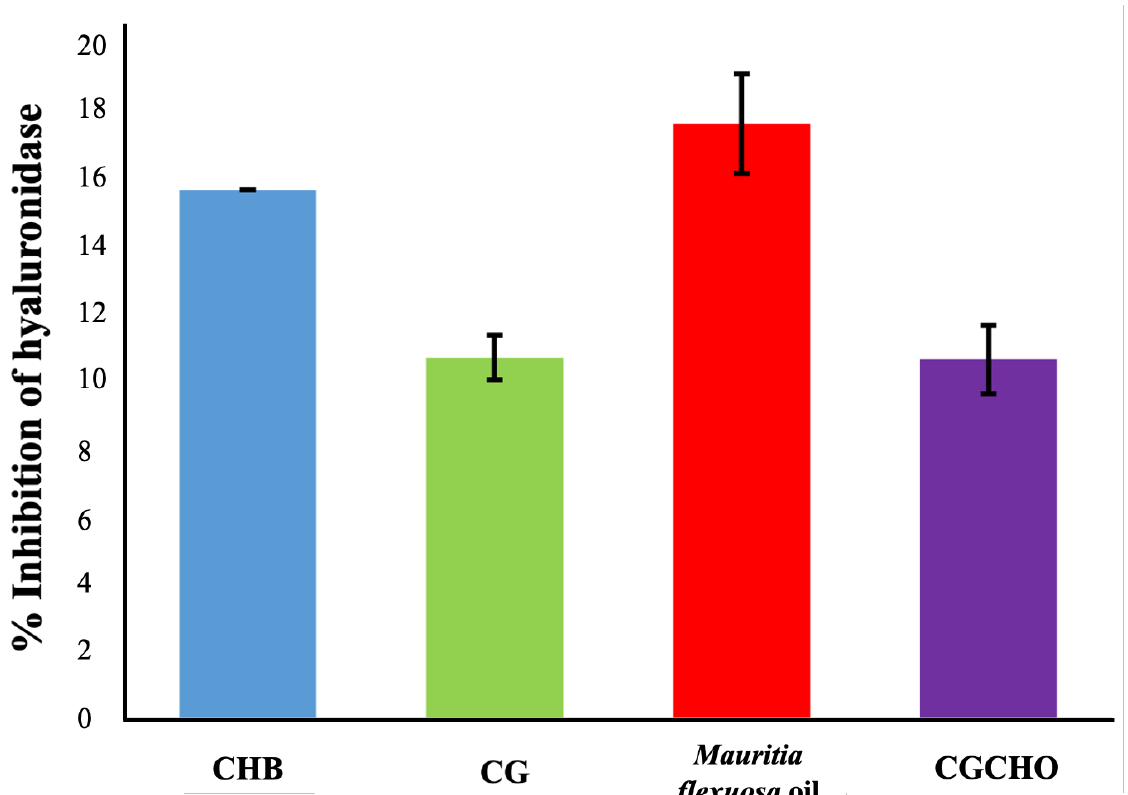
Figure 4. Inhibition of hyaluronidase activity by chicha gum (CG), Mauritia flexuosa oil, chicha gum/chitosan/ Mauritia flexuosa oil gel (CGCHO), and chitosan-based gel (CHB).